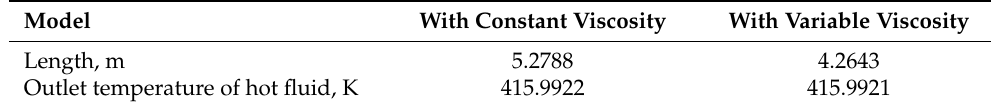
Table 2. Results of calculations.